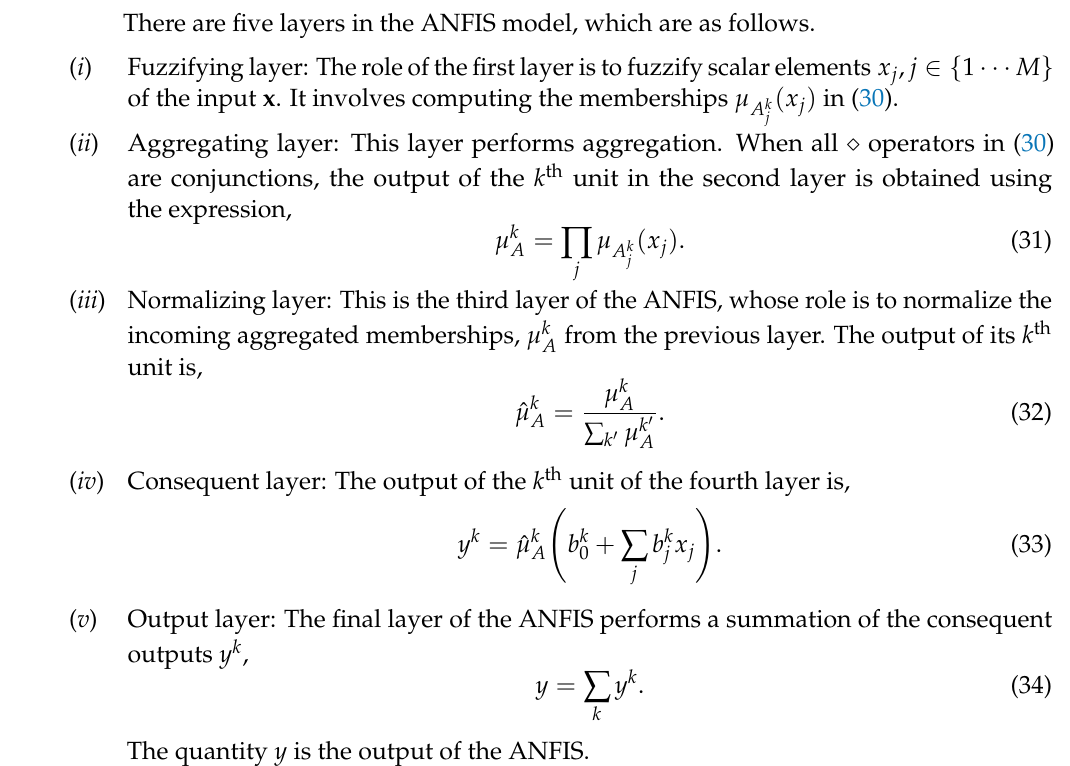
Figure 12. Type 1 TSK FIS. Shown are the membership functions of the fields (top) and the fuzzy rule base (bottom). The antecedents of the rules are the same as those in Figure